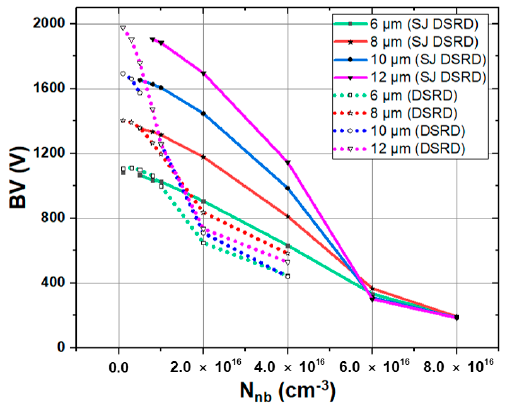
Figure 6. BV of conventional SiC DSRD and SJ SiC DSRD under different N nb and T nb .